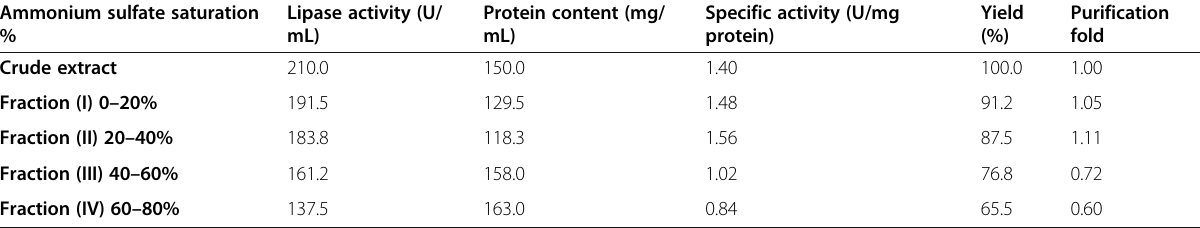
Table 1 Partial purification of lipase from R. oryzae R1 by fractional precipitation of ammonium sulfate Ammonium sulfate saturation %